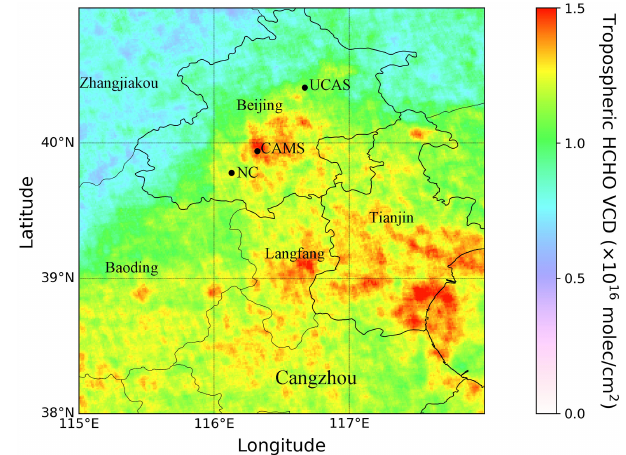
Figure 1. Annual average of the improved TROPOMI tropospheric HCHO VCD from August 2018 to July 2019 in Beijing and its sur- rounding region on a 0.01 ◦ × 0.01 ◦ grid. The black dots indicate the locations of MAX-DOAS